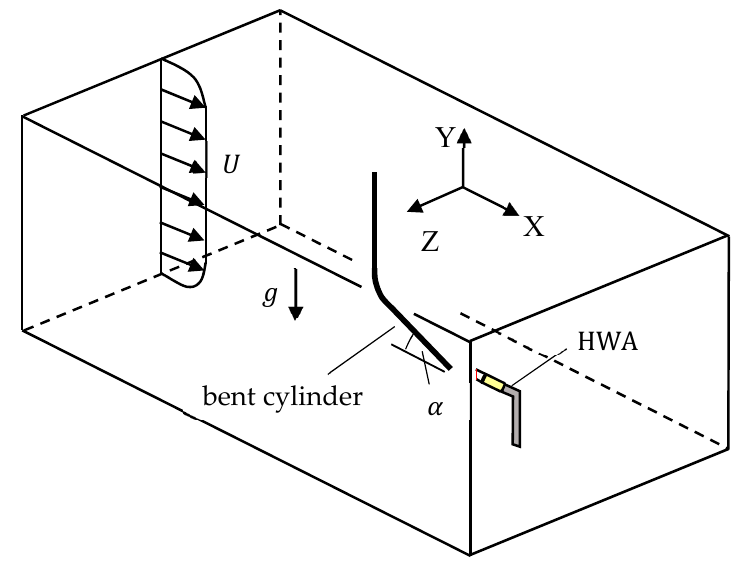
Figure 1. Schematic representation of the bent cylinder design adopted in the present study.